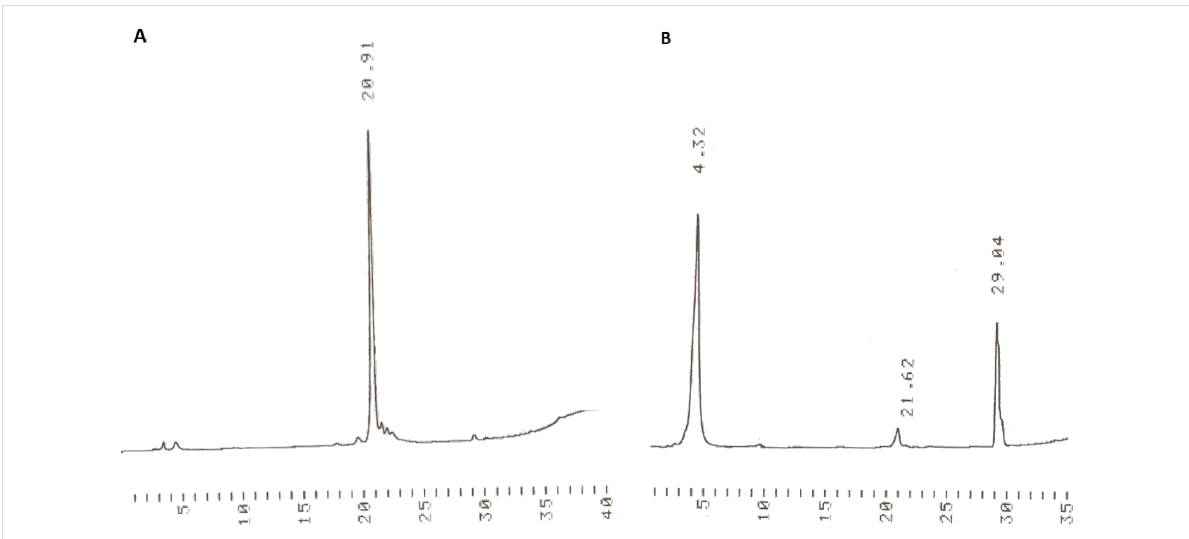
Figure 1: (A) HPLC traces for the precipitated support bearing phosphate-protected 3’-T-5’ monomer having the 5’-hydroxy group detritylated ( 7b ), and (B) HPLC traces of the filtrate after precipitation. For the chromatographic conditions, see gradient A in the Experimental section.